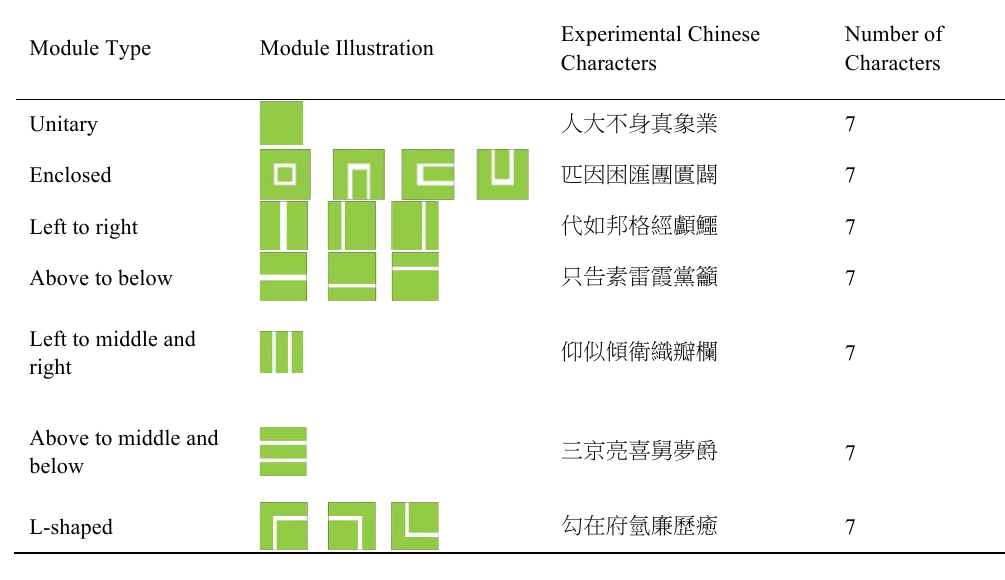
Form classification of Chinese character (Huang and Ma 2007)